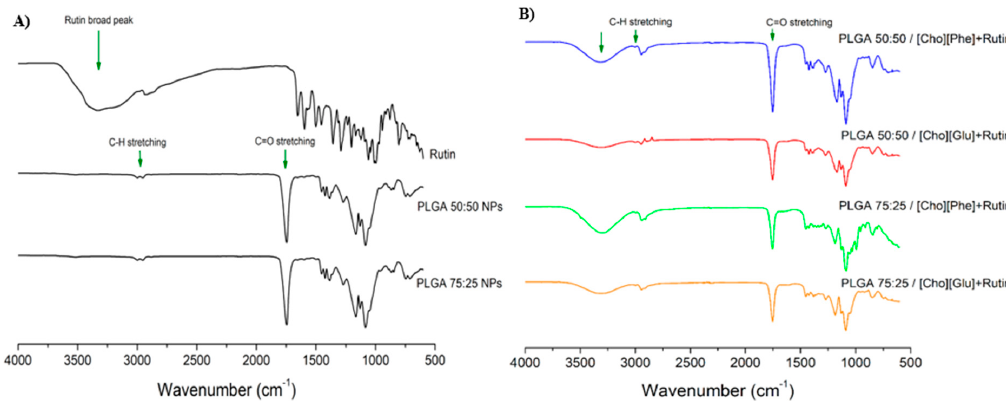
Figure 3. FTIR spectra of controls (Rutin, PLGA 50:50 and PLGA 75:25) ( A ) and rutin-loaded IL-PLGA nanoparticle hybrid systems ( B ), all obtained after freeze-drying.